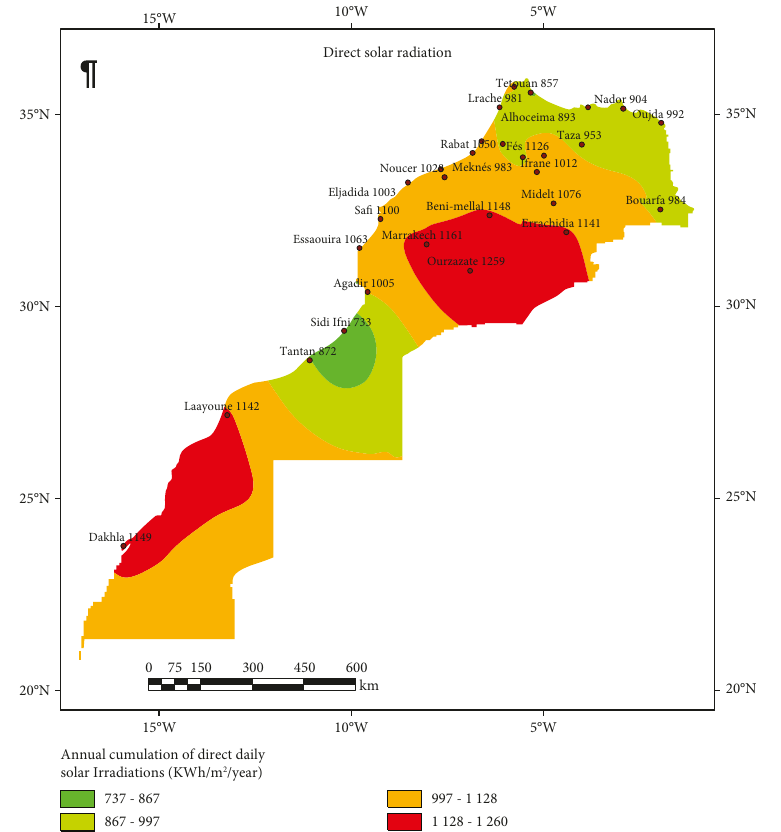
Figure 10: Map of annual cumulation of daily direct irradiations on a horizontal plane incident in the Moroccan territory. Map of direct solar radiation on a horizontal